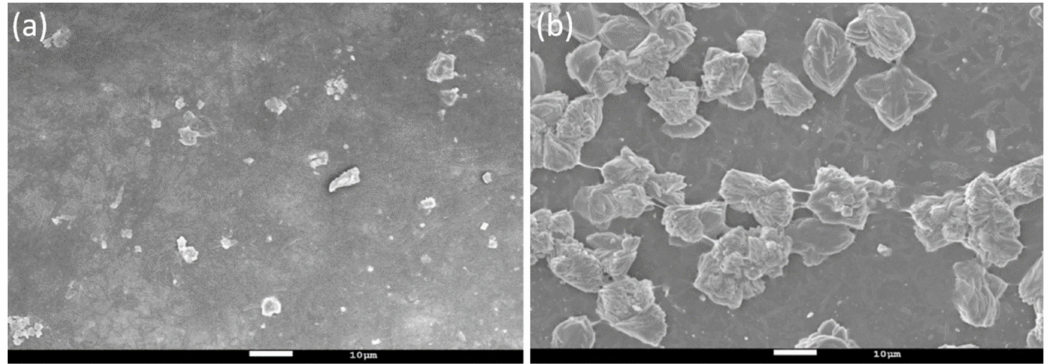
Figure 6. SEM image of ( a ) ZIF-8@PES w and ( b ) ZIF-8@PES